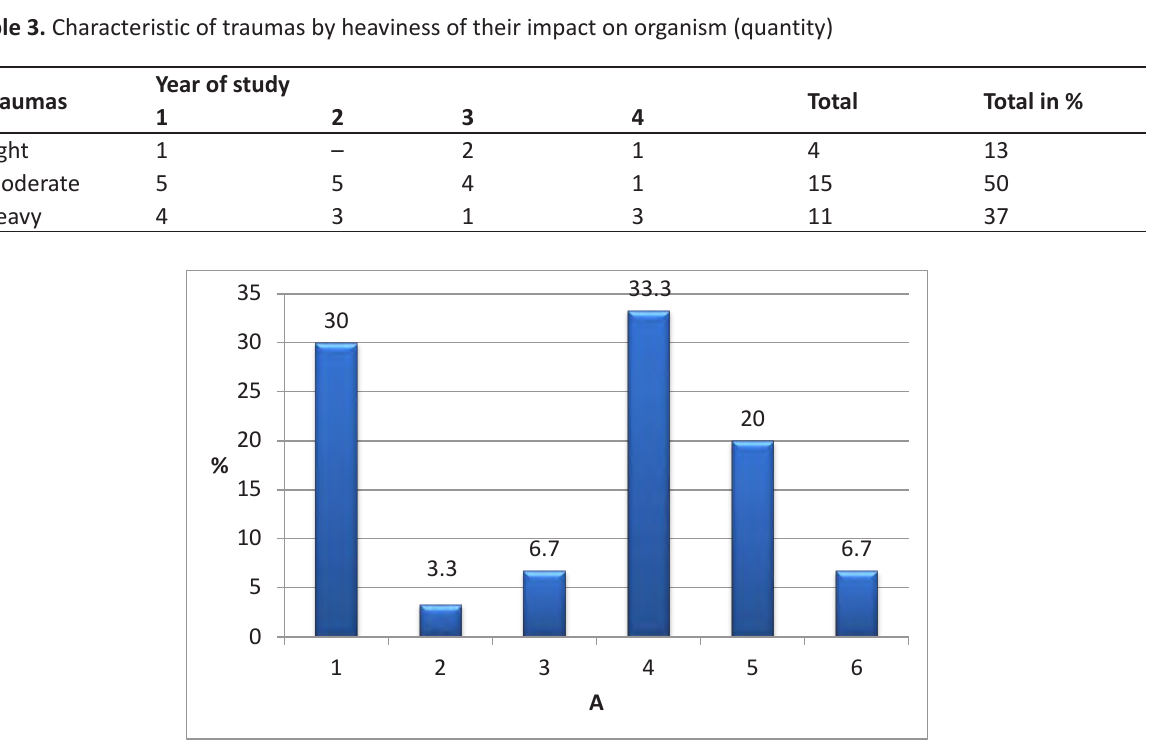
Fig. 2. Characteristic of traumas by the character of damage (%). A – Kinds of traumas: 1 –maims; 2 –fractures; 3 – dislocation; 4 – strains; 5 – bursts; 6 –